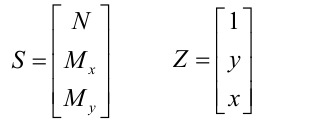
CG: Centro geométrico da seção transversal.